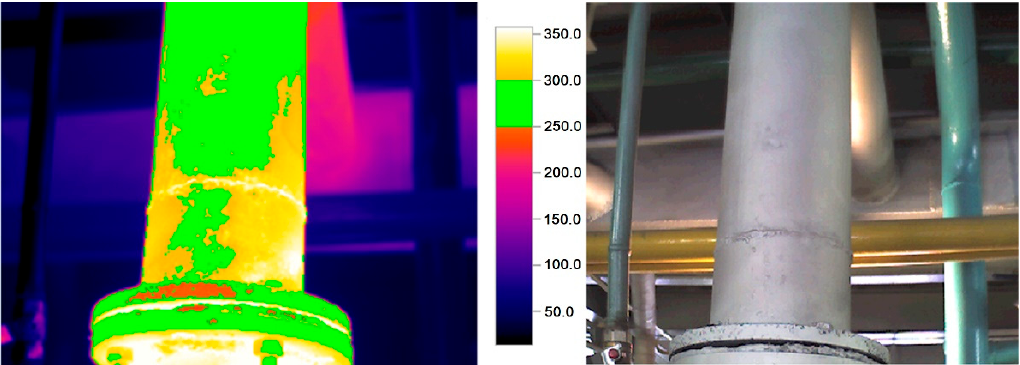
Figure 2. Thermal imaging of the chimney at 300 °C. Figure 2.